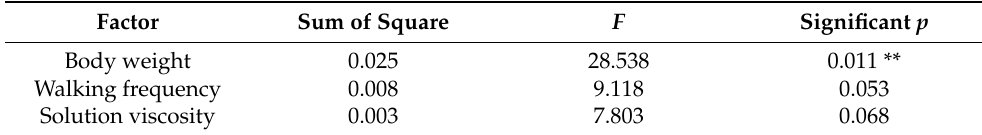
Table 6. Three-factor ANOVA using τ as the index.